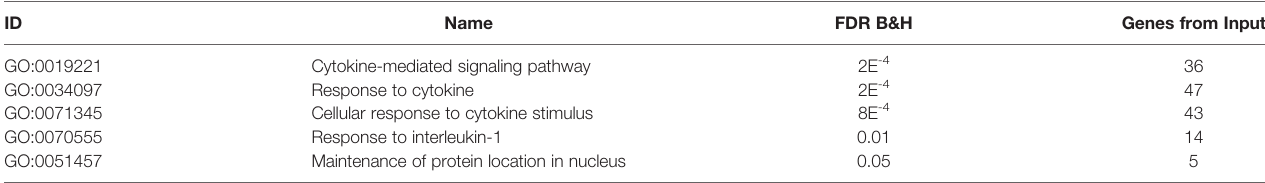
TABLE 3 | Enriched biological processes (B&H FDR < 0.05) for brain-stimulated vs. unstimulated MS blood cells, excluding DEGs between fl u-stimulated vs. unstimulated MS blood cells and between brain stimulated vs. unstimulated control blood cells.